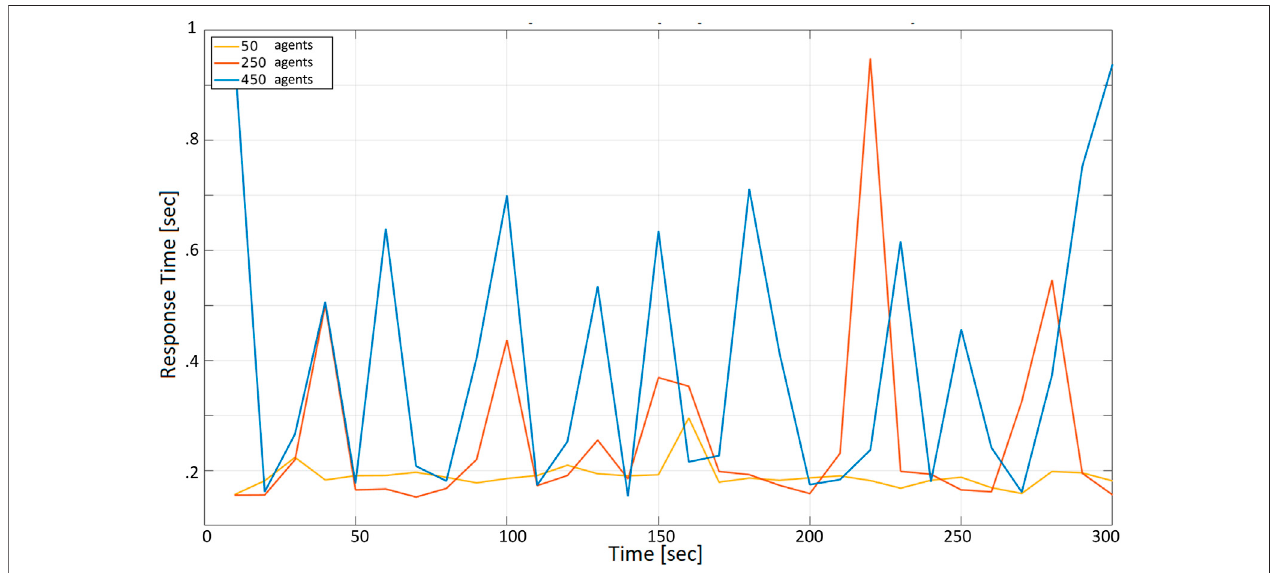
FIGURE 7 | Cloud response time with a request period r = 10 s with 50, 250, and 450 agents.